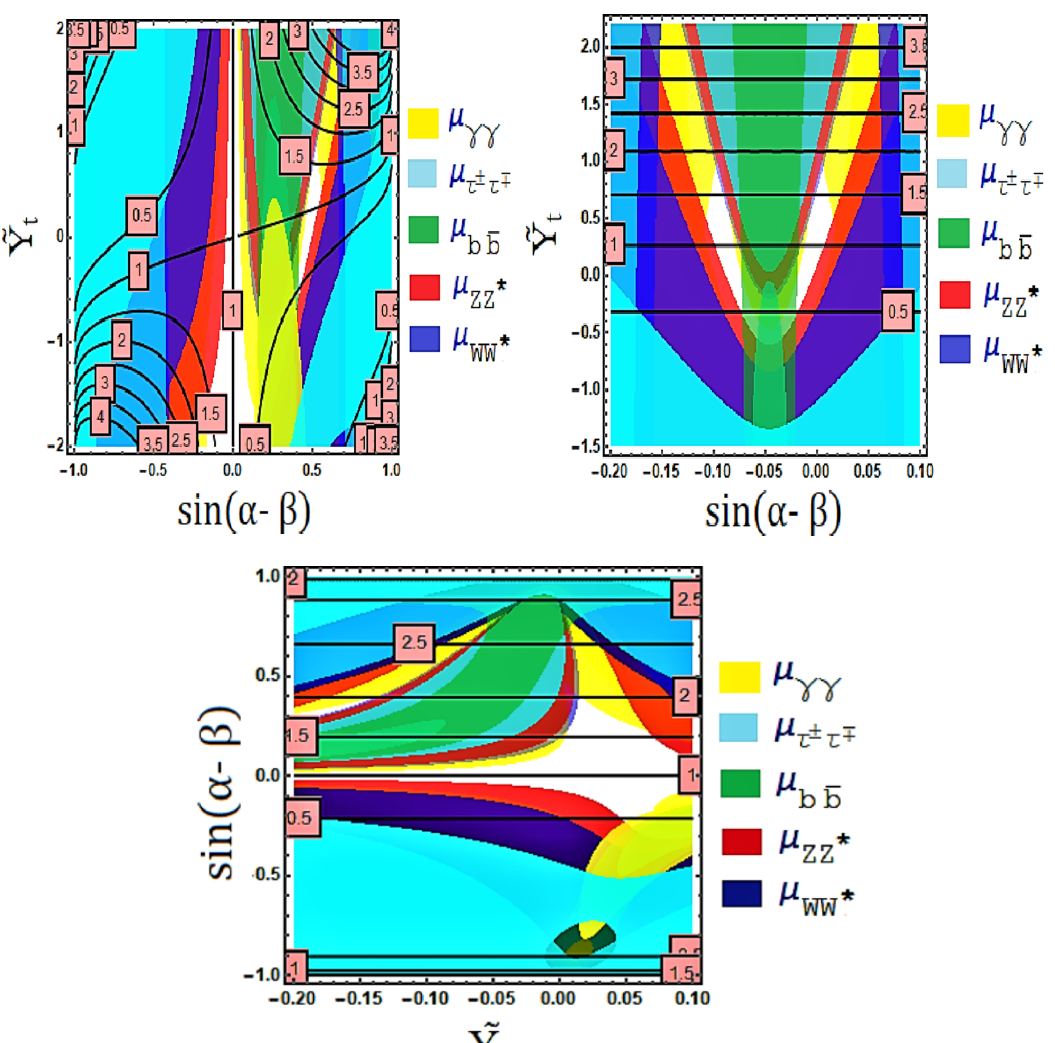
Figure 4 . Top Left: contour plot of (cid:22) t (cid:22) th in f ~ Y t ; sin( (cid:11) (cid:0) (cid:12) ) g plane. Here ~ Y b = (cid:0) 0 : 09 is kept (cid:12)xed. Top Right: contour plot of (cid:22) t (cid:22) th in f ~ Y t ; ~ Y b g plane. Here we choose sin( (cid:11) (cid:0) (cid:12) ) = 0 : 5. Bottom: contour plot of (cid:22) t (cid:22) th in f sin( (cid:11) (cid:0) (cid:12) ) ; ~ Y b g plane, with ~ Y t = 1 : 25 (cid:12)xed. The yellow, cyan, green, red and purple shaded regions are excluded from the signal strength limits for various decay modes ( (cid:13)(cid:13); (cid:28)(cid:28); b (cid:22) b; ZZ ? ; WW ? ) respectively. The white shaded region simultaneously satis(cid:12)es all the ex- perimental constraints.